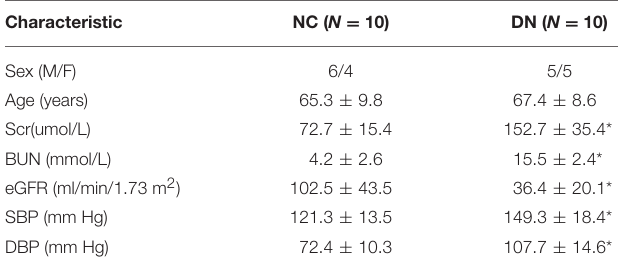
TABLE 1 | Baseline characteristics of patients with DN and normal controls.